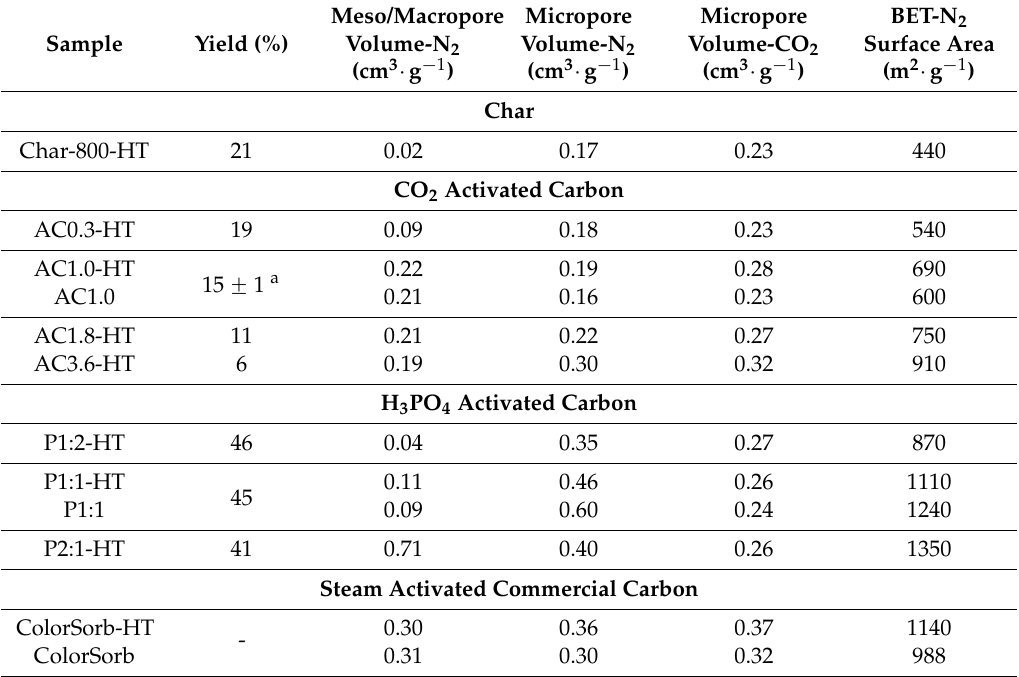
Table 1. Properties of activated carbon prepared by physical and chemical activation of wood, with and without heat treatment.